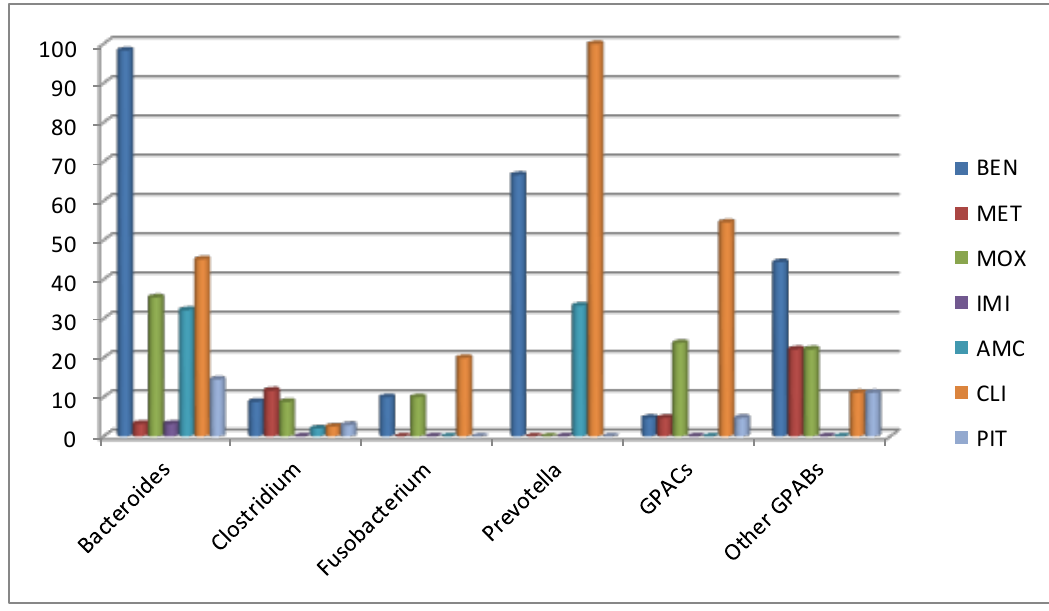
Figure 1. Resistance rate (%) of anaerobic bacteria against selected antimicrobial agents obtained from bacteraemias. BEN: benzylpenicillin; MET: metronidazole; MOX: moxifloxacin; IMI: imipenem; MER: meropenem; AMC: amoxicillin-clavulanate; CLI: clindamycin; PIT: piperacillin- tazobactam; GPACs: Gram-positive anaerobic cocci; GPABs: Gram-positive anaerobic